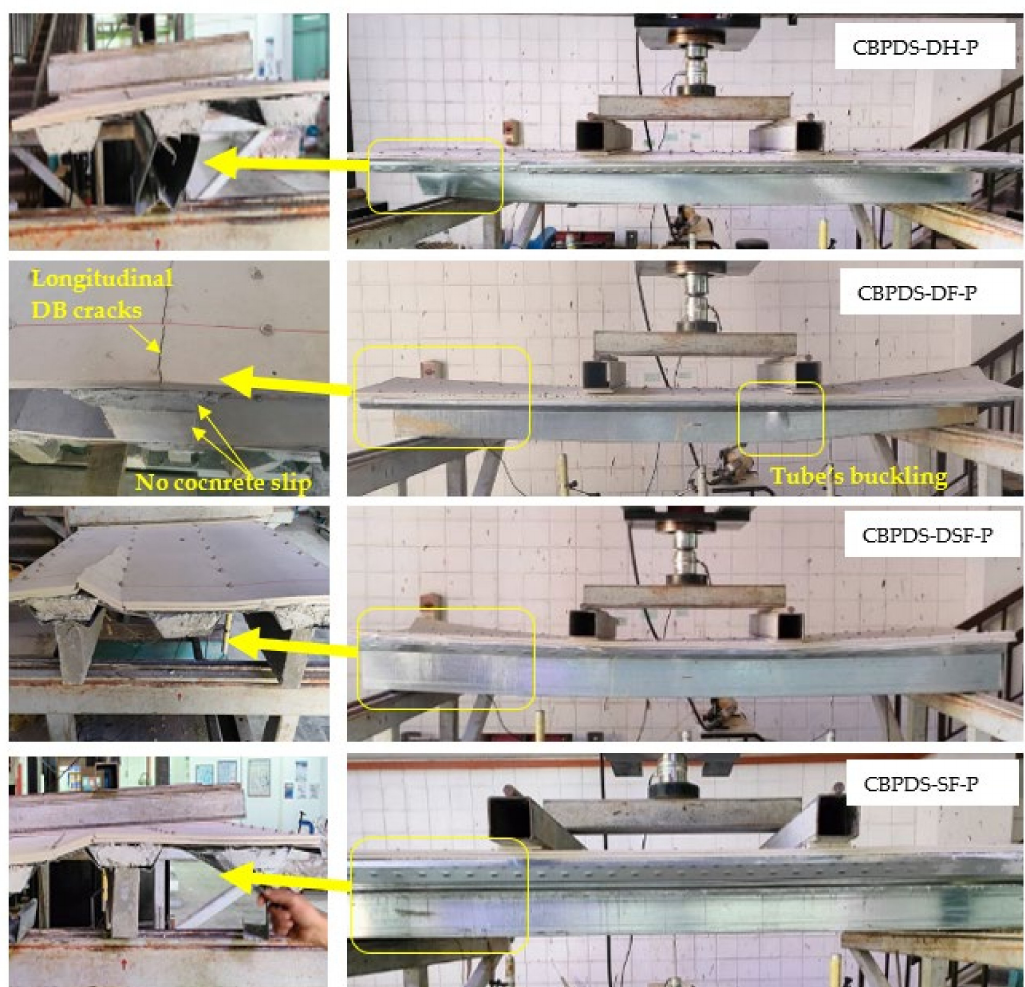
Figure 10. Bending behavior of the CBPDS specimens with parallel PSS